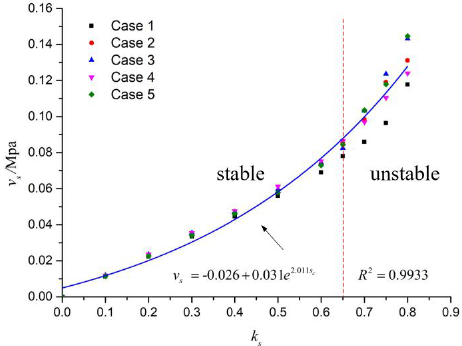
Figure 9. v s evolution curves with k s increasing.